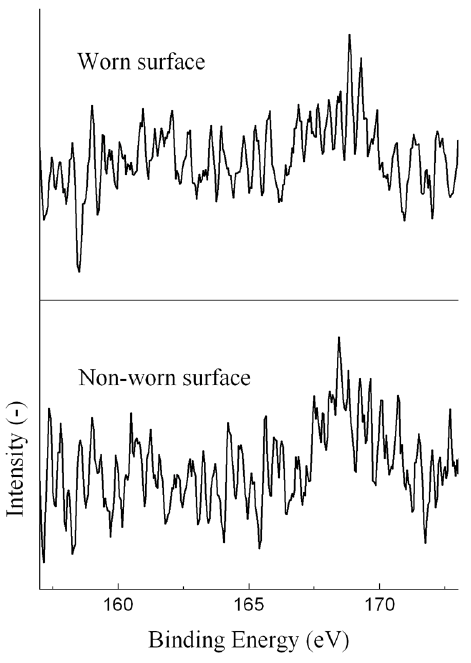
Figure 6. S 2p XPS spectra of the ball lubricated with the EO50.